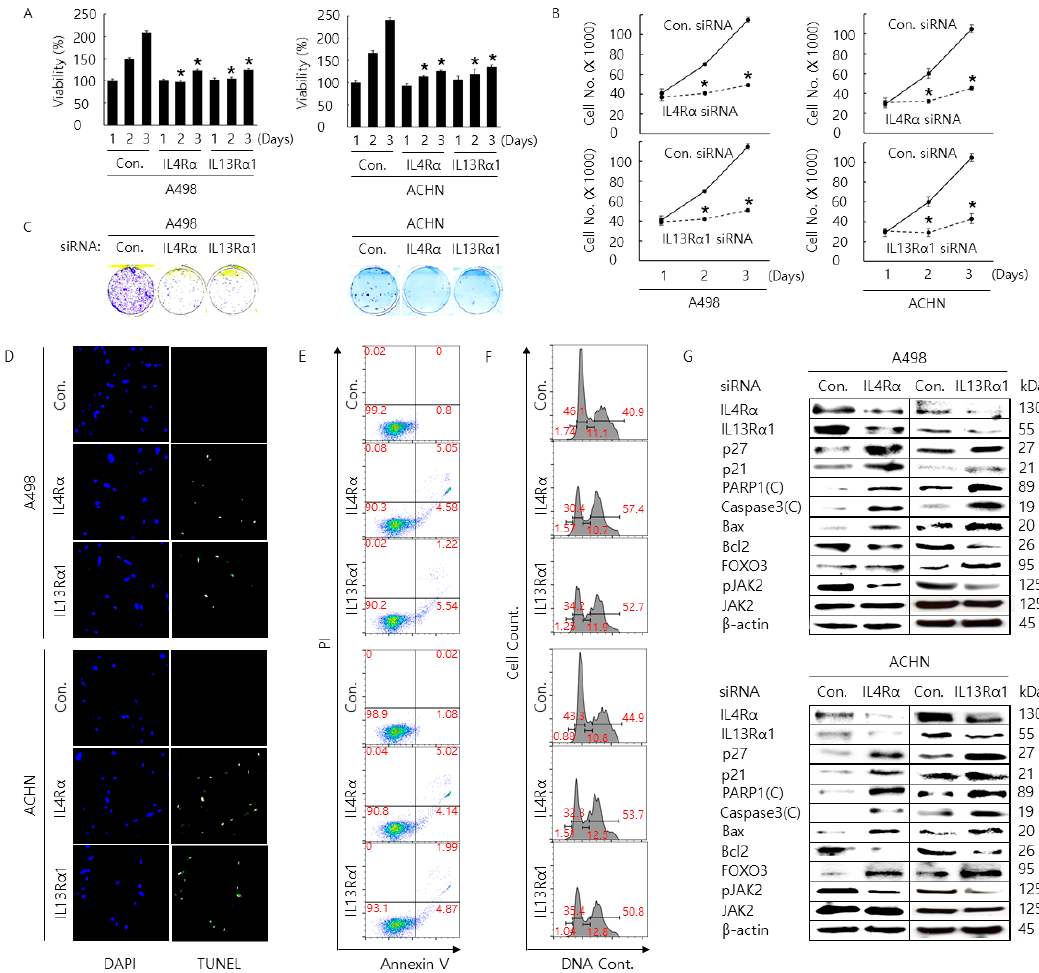
Figure 2. Anti-cancer effect by transfection of siRNA against IL4R α or IL13R α 1 in A498 and ACHN